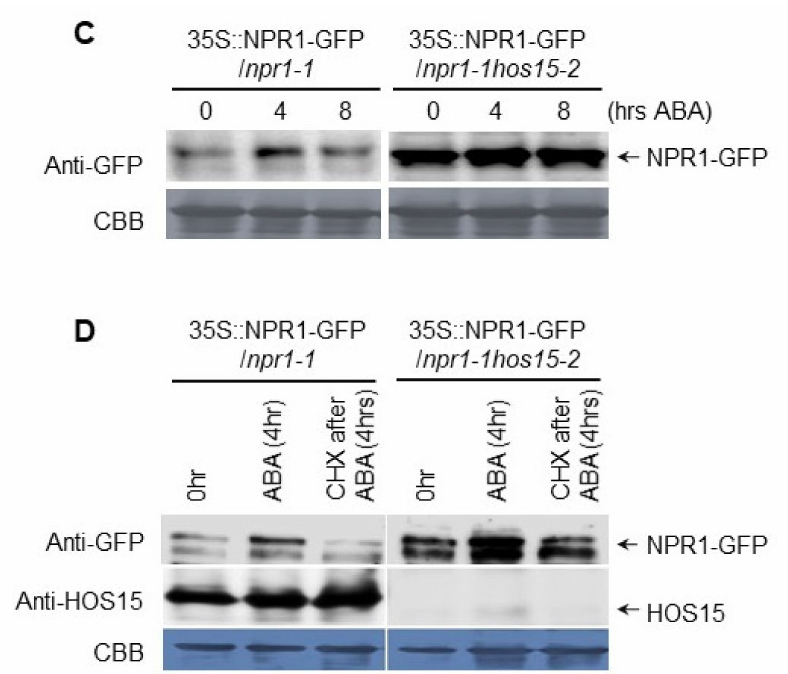
Figure 3. HOS15 interacts with and regulates NPR1 protein abundance. ( A ) HOS15 interacts with NPR1 in yeast. The co-transformed yeast strains were plated onto the control − TL selective − TLH media. The combinations with the empty plasmids were used as negative controls. BD, pDEST32 (bait plasmid); AD, pDEST22 (prey plasmid). ( B ) Co-immunoprecipitation assay between HOS15 and NPR1. Protein extracts obtained from N. benthamiana leaves infiltrated with Agrobacterium tumefaciens harboring 35S::HOS15-GFP and 35S::NPR1-HA were analyzed using anti-GFP and anti-HA antibodies, respectively. The protein extracts (input) were immunoprecipitated using anti-GFP antibody. The immunoblots were analyzed using anti-GFP and anti-HA antibodies to detect the interaction between HOS15 and NPR1. ( C ) The NPR1 protein degradation was determined using 10-day-old seedlings of 35S::NPRI-GFP / npr1-1 and 35S::NPRI-GFP / npr1-1 hos15-2 treated with 100 µ M ABA. The samples were collected at the indicated time point, and NPR1 protein level was measured using anti-GFP antibody. ( D ) Ten-day-old seedlings of 35S::NPRI-GFP / npr1-1 and 35S::NPRI-GFP / npr1-1